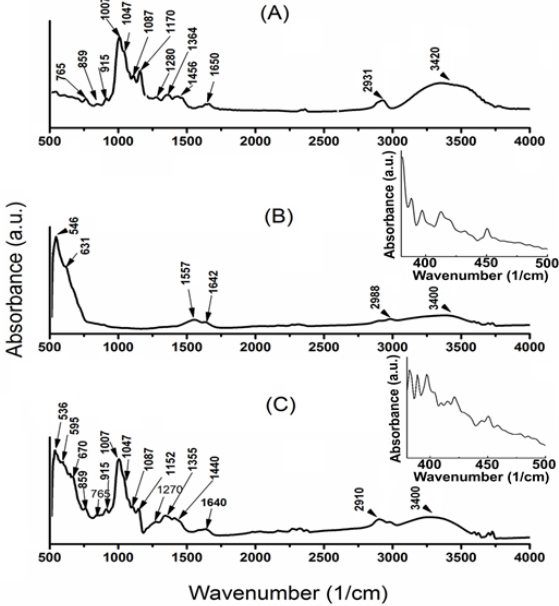
Figure 3. ATR-FTIR spectra of ( A ) dextran ( B ) maghemite and ( C ) maghemite coated with dextran. Metals 2017 , 7 , 63